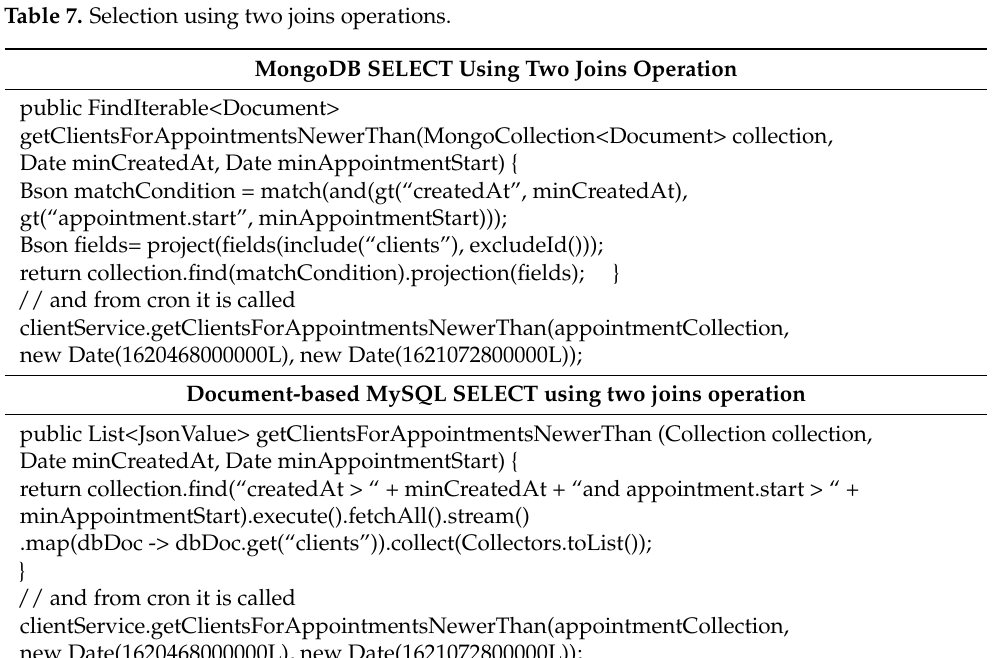
Table 7. Selection using two joins